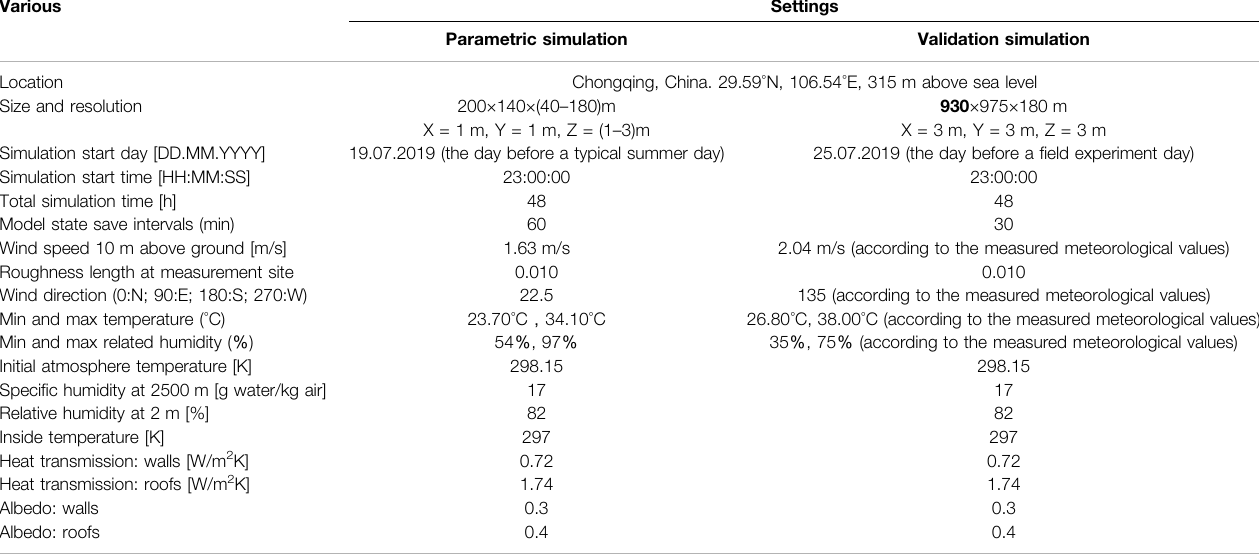
TABLE 3 | Conditions used in the simulation with ENVI-met. Various